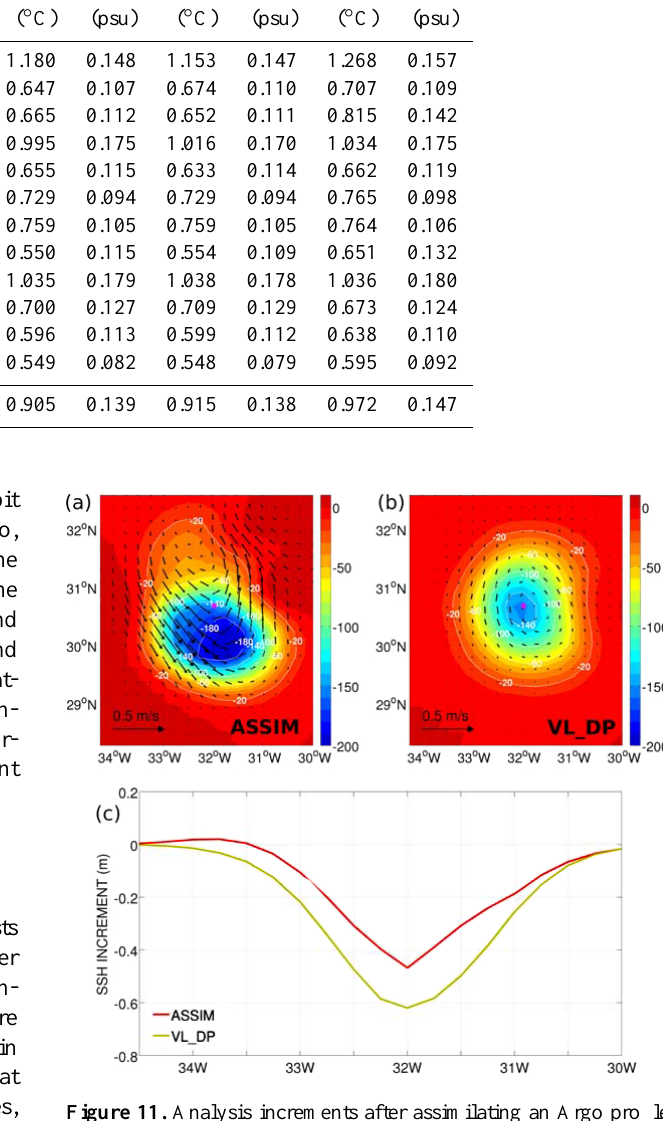
Figure 11. Analysis increments after assimilating an Argo profile located at 30.72 ◦ N and 31.98 ◦ W on 1 January 2010 of: (a) layer thickness (unit: m) and current components (unit:ms − 1 ) in the 12th layer for the experiment ASSIM, (b) layer thickness (unit: m) and current components (unit:ms − 1 ) in the 12th layer for the experi- ment VL_DP and (c) SSH (unit: m) along 30.72 ◦ N for the experi- ment ASSIM (red) and VL_DP (dark dashed yellow). The pink dot represents the location of the Argo